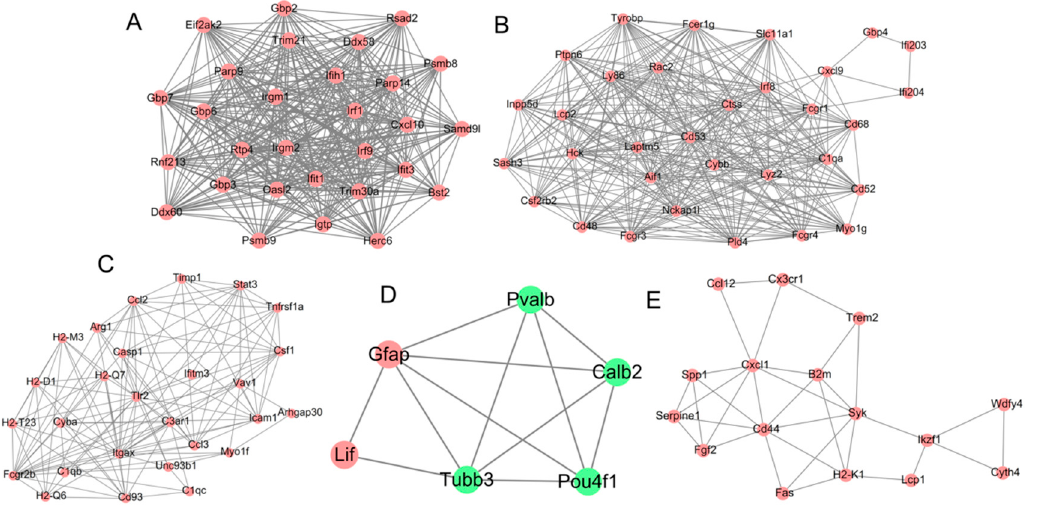
Figure 4. Modules extracted from the protein–protein interaction network. ( A ) module 1; ( B ) module 2; ( C ) module 3; ( D ) module 4; ( E ) module 5. Red, upregulated genes; green, downregulated genes.